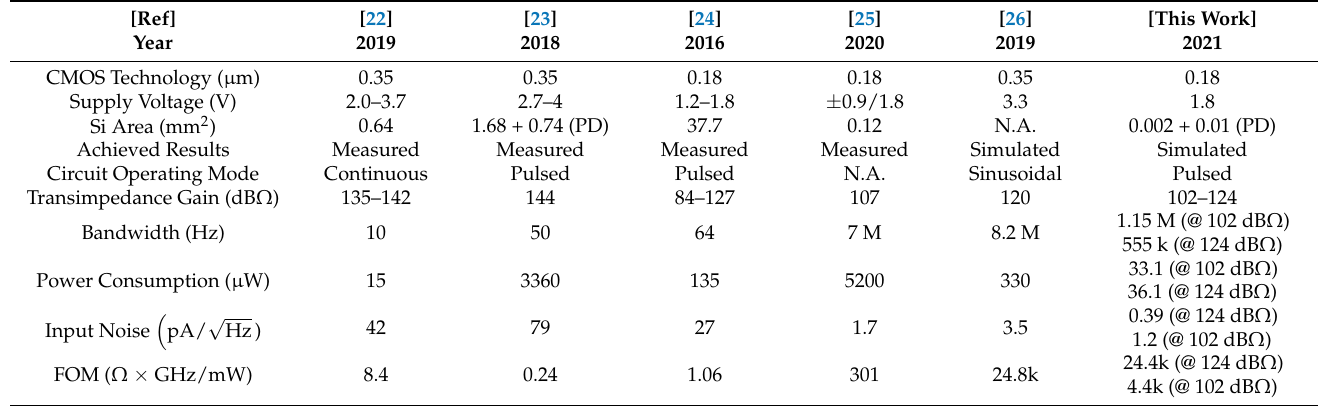
Table 2. Main circuit characteristics and its comparison with the